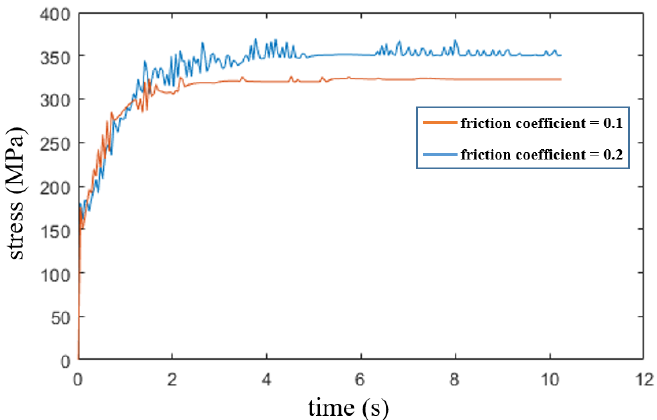
Figure 8. Distribution of stress according to velocity difference between roller and steel plate.